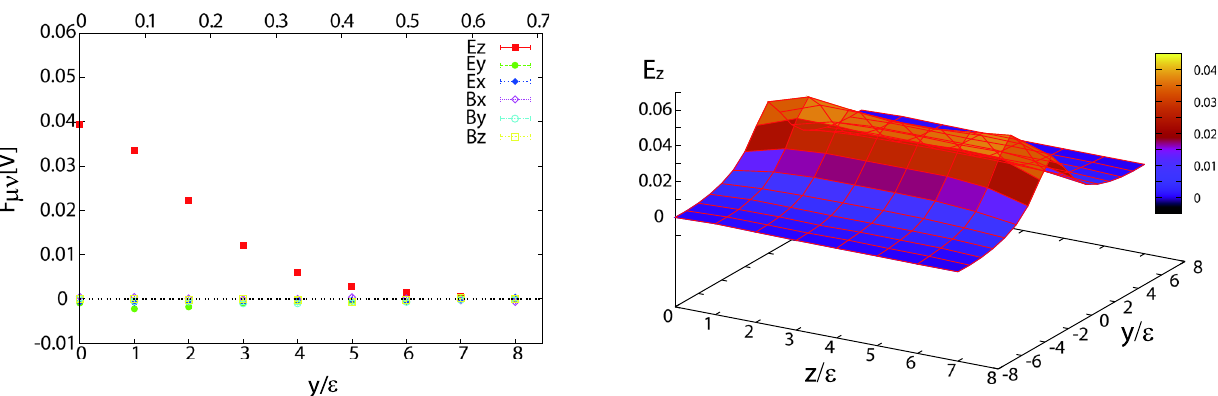
Fig. 3 [17] (Left panel) the gauge-invariant chromofields F μν [ V ] in (7) under the same conditions as those in Fig. 2. (Right panel) the distribution of E z [ V ] in y − z